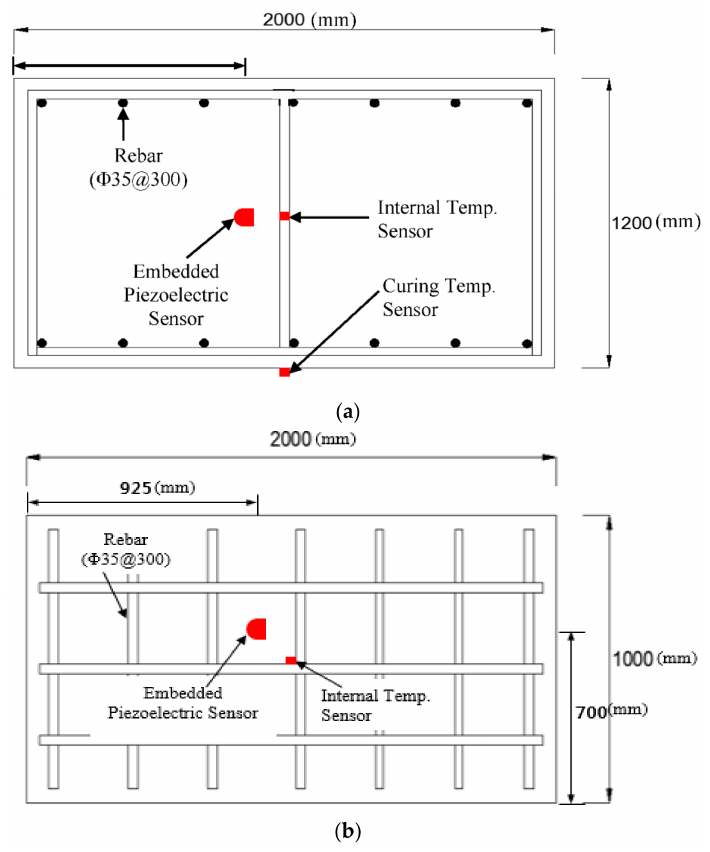
Figure 3. ( a ) Geometric information of the concrete specimen and sensors (planar view); ( b ) Geometric information of the concrete specimen and sensors (front/elevated